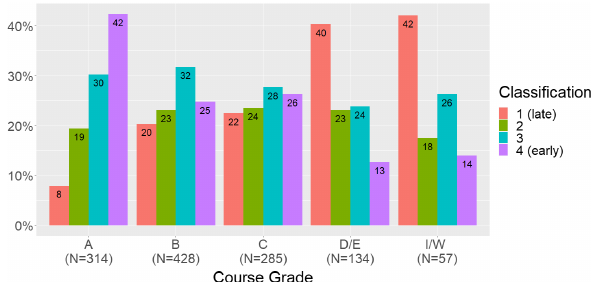
FIG. 5. Proportion of students that received the indicated course grade for each completion